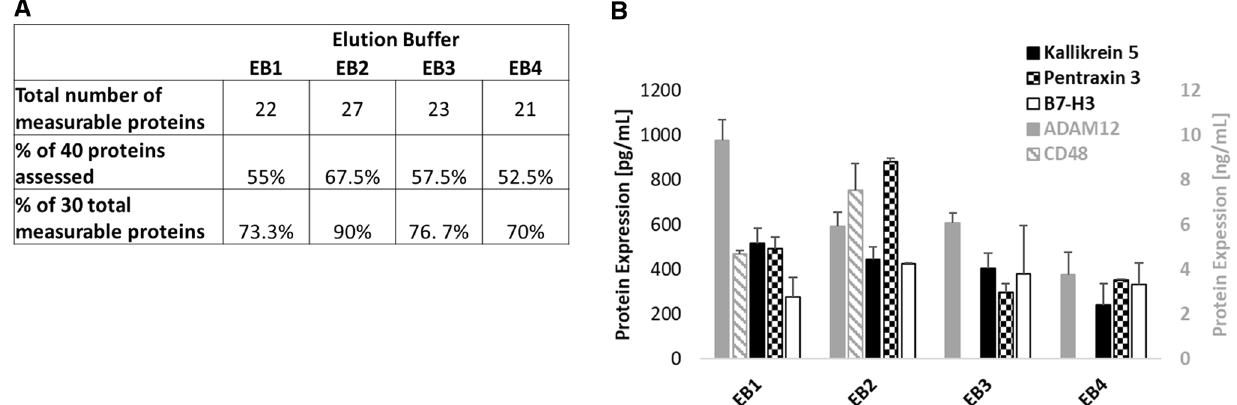
Figure 4. Optimization of Elution buffer composition for protein extraction in DBS samples. 4 different elution buffers: 1 × PBS (EB1), 1 × PBS containing 0.1% Tween-20 (EB2), 1 × PBS containing 10% casein and 50% BSA (EB3), and 1 × PBS containing 10% casein, 50% BSA, and 0.1% Tween-20 (EB4) were used to elute 3 DBS samples each. ( A ) The number and percentage of 40 proteins that were quantitatively assessed and measurable with each elution buffer. ( B ) Concentrations and variance as evidenced by the standard error of 5 proteins compared across the 4 different elution